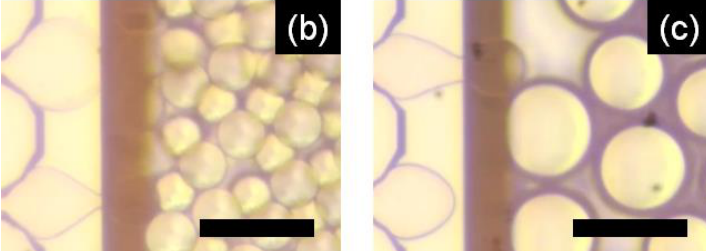
Figure 7. ( a ) Variation of mean diameter ( d m , circles) and droplet detachment time (squares) as a function of the flow velocity of the dispersed phase that flows in a channel, and typical optical photomicrographs of droplets generated from channels ( b ) below the critical flow velocity (1.3 mm/s) and ( c ) above the critical flow velocity (3.9 mm/s). MC-B was used. SC concentration was 3 wt%, and emulsification temperature was 60 °C. The scale bars in ( b ) and ( c ) are 50 µm.